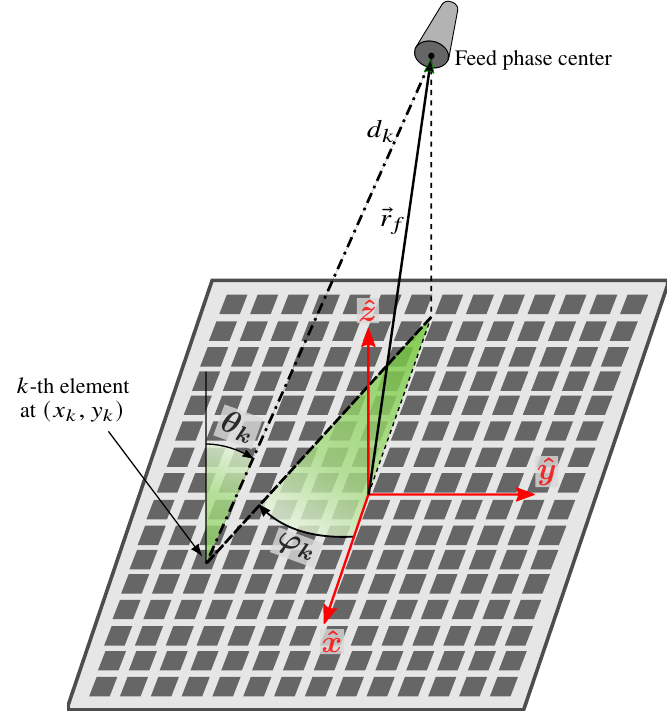
Figure 1. Sketch of a single-offset reflectarray configuration showing the definition of the angle of incidence ( θ , ϕ ) experienced by the k th element. The angle of incidence depends on the feed phase center position (cid:126) r f and the element coordinates ( x k , y y ) . For the k th element shown in this example, the value of ϕ k is negative since y k <